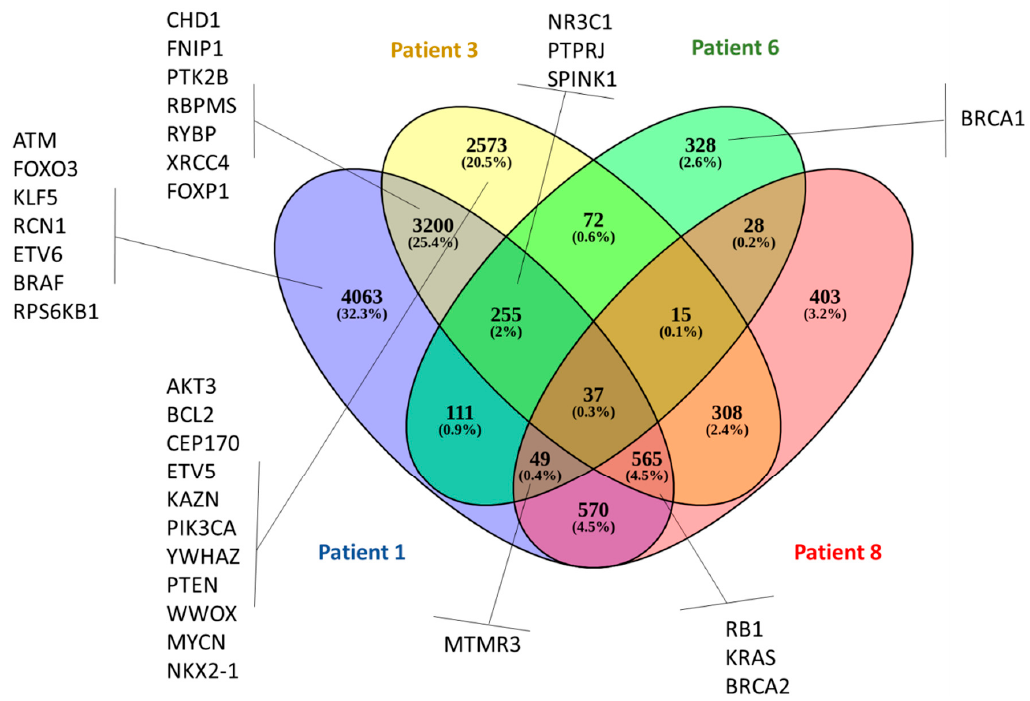
Figure 8. Venn diagram representing genes with amplification in at least one copy in patients 1 (blue), 3 (yellow), 6 (green), and 8 (red). The genes highlightened are similar genes’ amplification found in a previous study using CTCs from clinically localized high-risk prostate cancer (Friedlander et al. 2019) [52]. Some of the affected genes were also found by Ikeda et al. 2019 [53]. The list with the 37 commonly amplified genes is shown in Supplementary Materials Table 3. Table 4. Gene set enrichment analysis of the 37 shared amplified genes using the Reactome database found in patients 1, 3, 6, and 8.